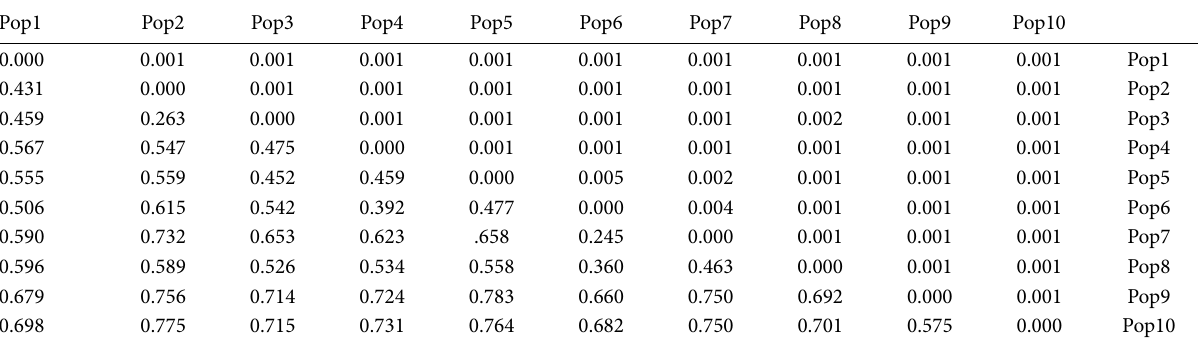
Table 6. Pair-wise AMOVA among P. afar populations. PhiPT Values below diagonal. Probability, P(rand >= data) based on 999 permuta- tions is shown above